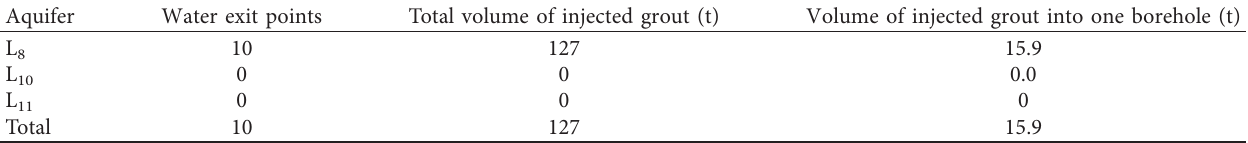
Table 4: Type 1 fracture.